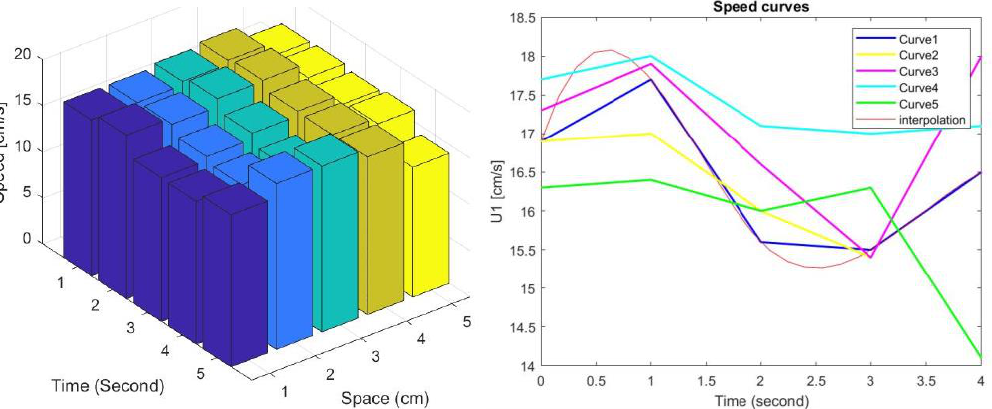
Figure 11. Distribution speed variations ( left ), and sensitivity analysis for U 1 acquisitions of Table 2 ( right